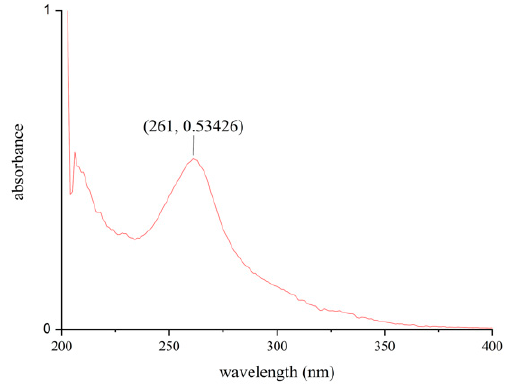
Figure 3. UV scanning spectra of isoflavone extracts from natto.